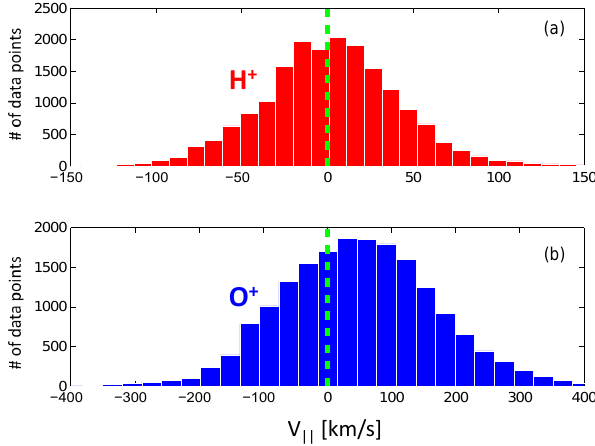
Figure 5. The occurrences of H + (a) and O + (b) parallel bulk ve- locities for northward IMF and large clock angles, 60 ◦ < | θ | < 90 ◦